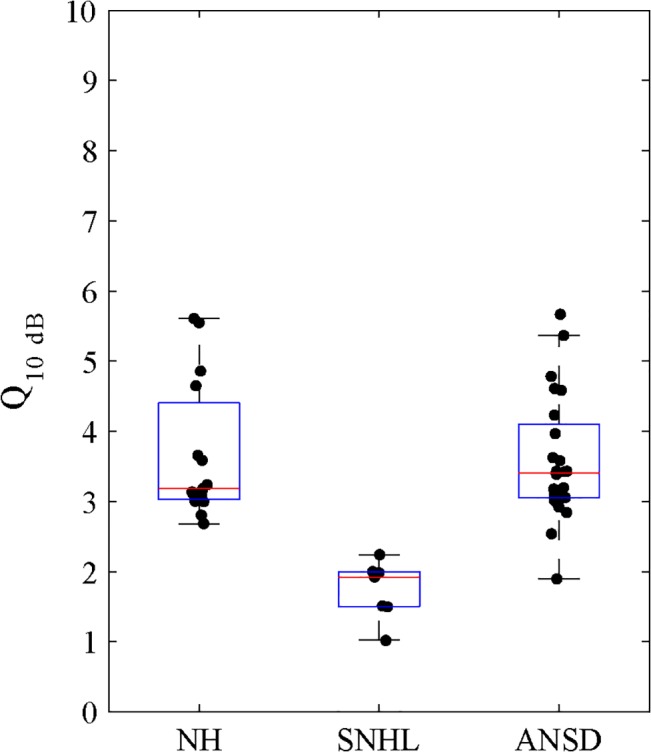
The Q10dB values of psychophysical tuning curves for subjects with NH, with SNHL, and with ANSD.The horizontal lines of the box represent 25th, 50th, and 75th percentiles and the whiskers represent the range of the data. Individual subjects are represented by the solid dot.